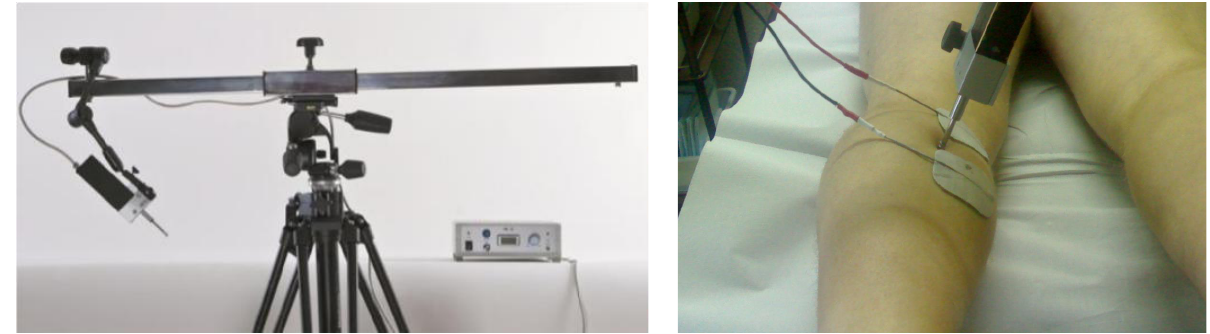
Figure 3. A TMG apparatus with a linear displacement sensor ( left ) was used to detect contractile properties while two self-adhesive electrodes were positioned distal and proximal to the thickest part of the muscle belly ( right